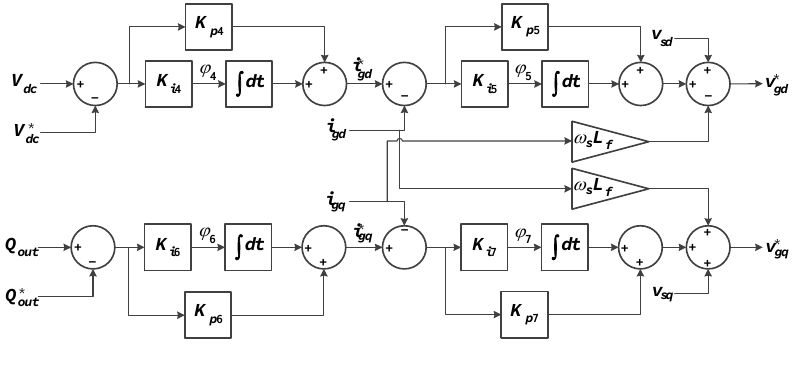
Figure 4. Control structure of